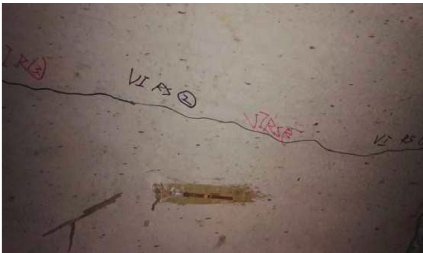
Figure 18: Destruction diagram of the right spandrel at the en- trance of the tunnel.